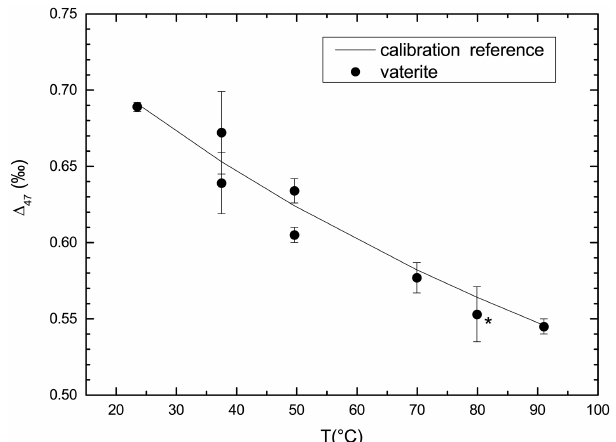
Figure 11. CaCO 3 formed per experiment vs. duration. The initially dissolved CaCO 3 amount was identical in all experiments (about 370mg). The yield of experiments conducted below 80 ◦ C follows an exponential relationship with